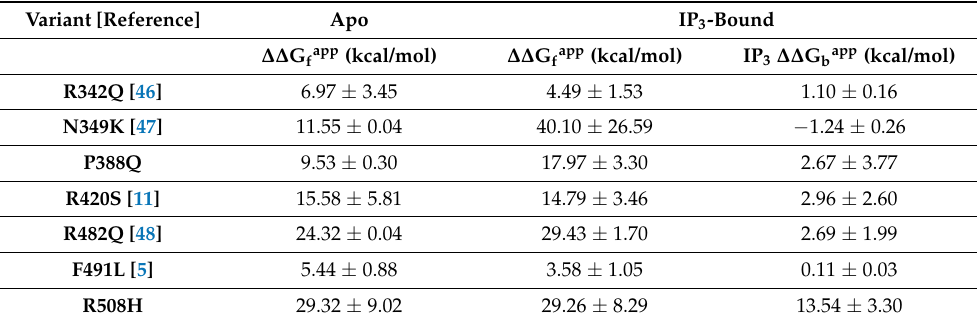
Table 3. Effects of TULP1 missense variants found in this study on the apparent relative stability ( ∆∆ G fapp ) and affinity for IP 3 ( ∆∆ G bapp